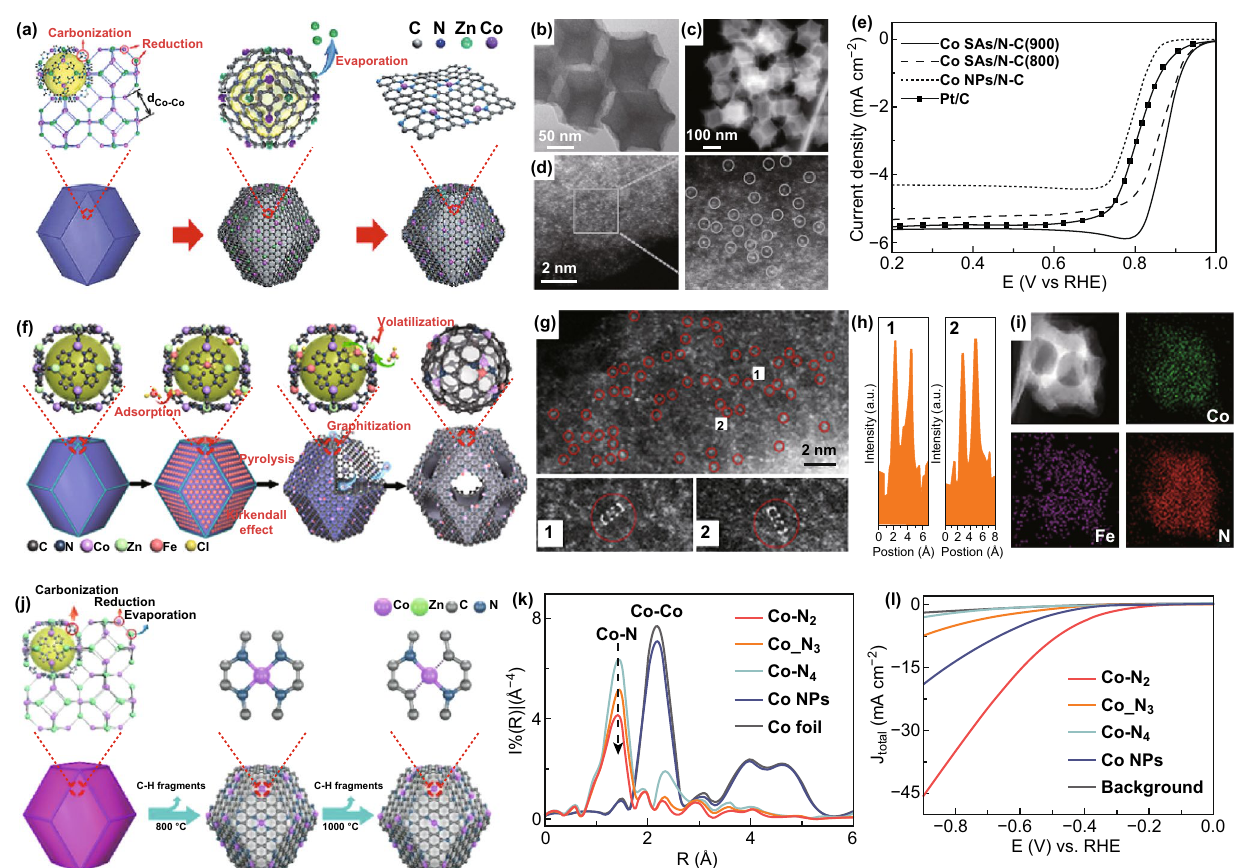
Fig. 3 a The schematic illustrations of Co SAs/N–C. b TEM, c, d HAADF-STEM images of Co SAs/N–C(800). e LSV of Co SAs/N–C, Co NPs-N/C, and Pt/C in O 2 -saturated 0.1 M KOH solutions. f Preparation of (Fe, Co)/N–C. g HAADF-STEM of (Fe, Co)/N–C. h Corresponding intensity profiles obtained on the zoomed areas in g . i Corresponding EELS mapping of Co, Fe, and N. j Schematic formation process of Co–N